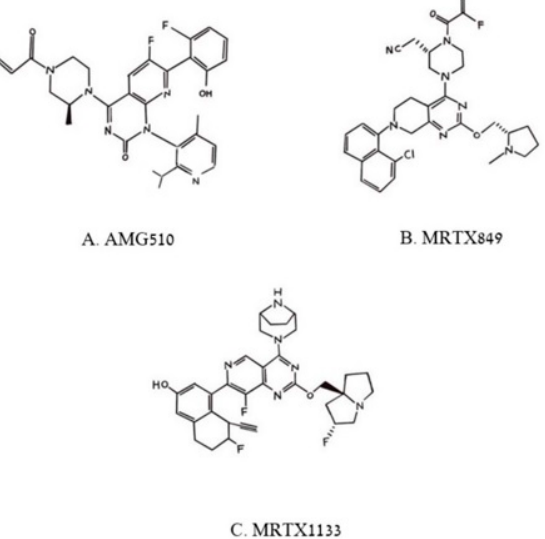
Figure 6. Pincus et al. Chemical structures of three poly aromatic ring molecules, AMG500 ( A ), MRTX849 ( B ) and MRTX 1139 ( C ) that insert into a groove formed by the switch 2 domain, its α 2 helix and its α 3 helix. The first two compounds, ( A , B ), bind uniquely to G12C-K-RAS-p21-GDP, the third, ( C ), binds to G12D-K-RAS-p21-GDP.